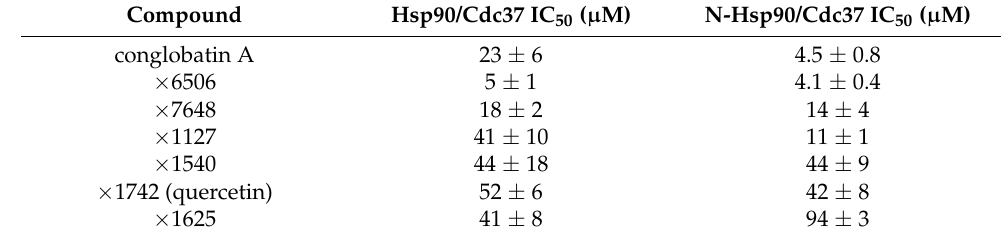
Table 1. Inhibition of the Hsp90/Cdc37 interaction measured in the split Renilla luciferase assays. Compound Hsp90/Cdc37 IC 50 ( µ M) N-Hsp90/Cdc37 IC 50 ( µ M) conglobatin A 23 ± 6 4.5 ± 0.8 × 6506 5 ± 1 4.1 ± 0.4 × 7648 18 ± 2 14 ± 4 × 1127 41 ± 10 11 ± 1 × 1540 44 ± 18 44 ± 9 52 ±